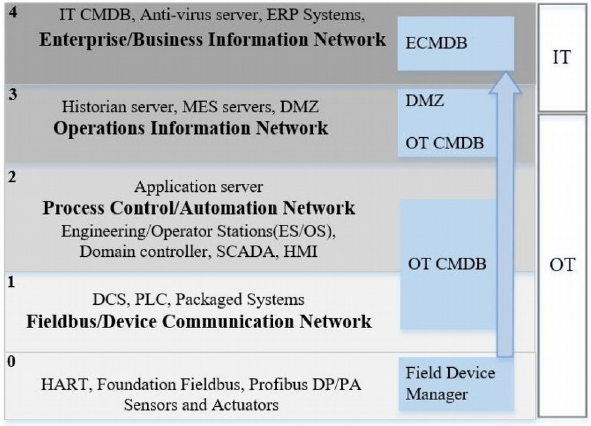
Figure 4. Proposed application of CMDB in the OT domain (Modified